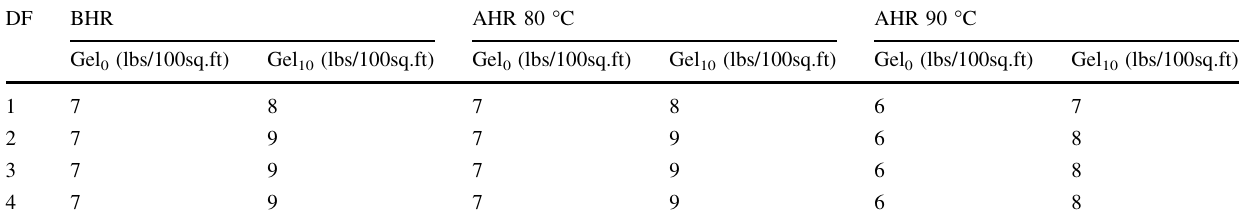
Table 8 Gel strength of CTAB, KCl mud after hot rolling DF BHR AHR 80 (cid:3) C Gel 0 (lbs/100sq.ft)